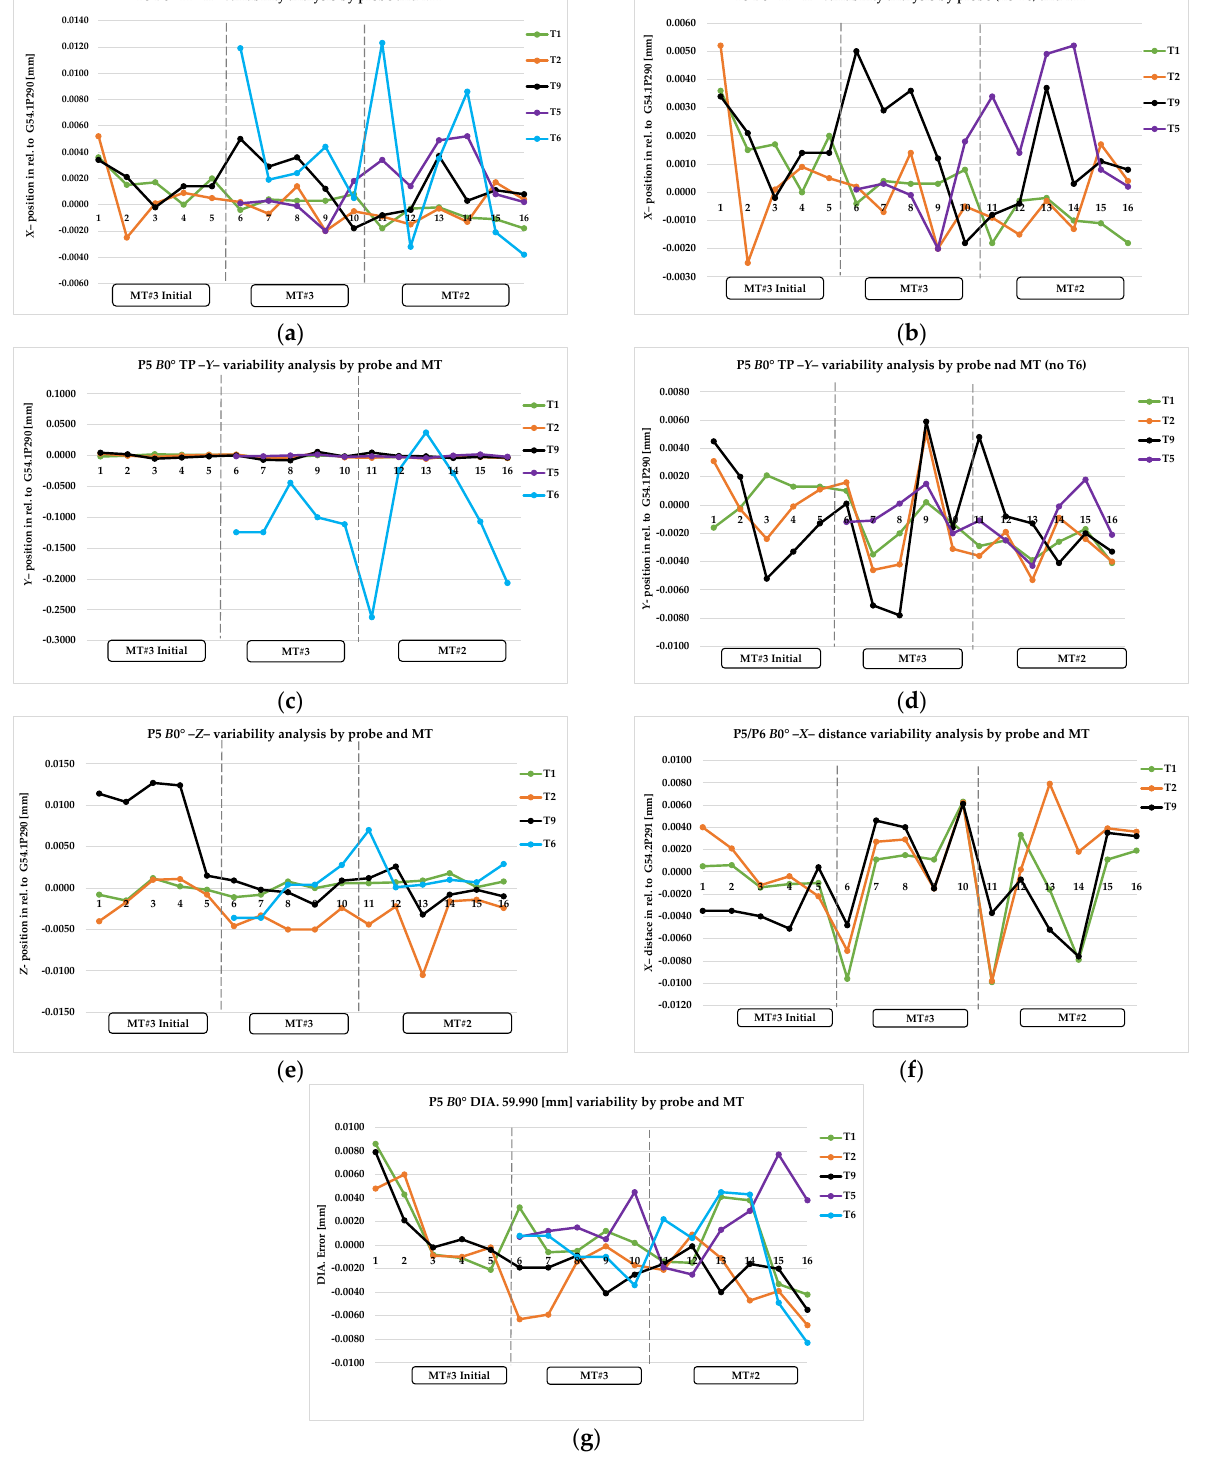
Figure 11. Analysis of P5 area measurement for the probes T1, T2, T9, T5 ( B 0° head), and T6 ( B 90° head): ( a ) variability of hole true position— X direction, all probes; ( b ) variability of hole true position— X direction, T6 probe error hidden; ( c ) variability of hole’s true position— Y direction, all probes; ( d ) variability of hole’s true position— Y direction, T6 probe error hidden; ( e ) variability of Z – direction distance; ( f ) variability of X – direction distance; ( g ) variability of master hole size.